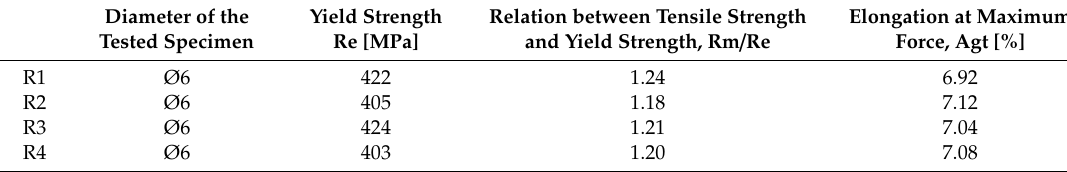
Figure 5. ( a ) Testing of the concrete compressive strength, ( b ) tensile strength testing of the steel for reinforcement. Table 6. The results of tensile splitting strength of steel for reinforcement.